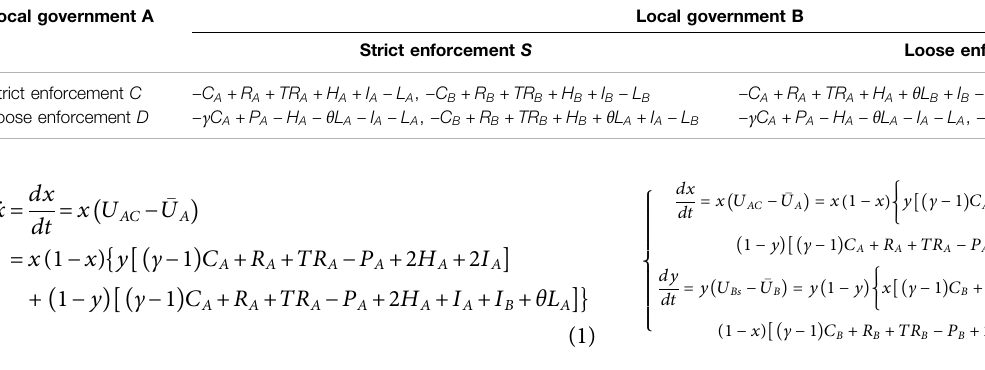
TABLE 2 | The utility matrix of government A and B under different strategies. Local government